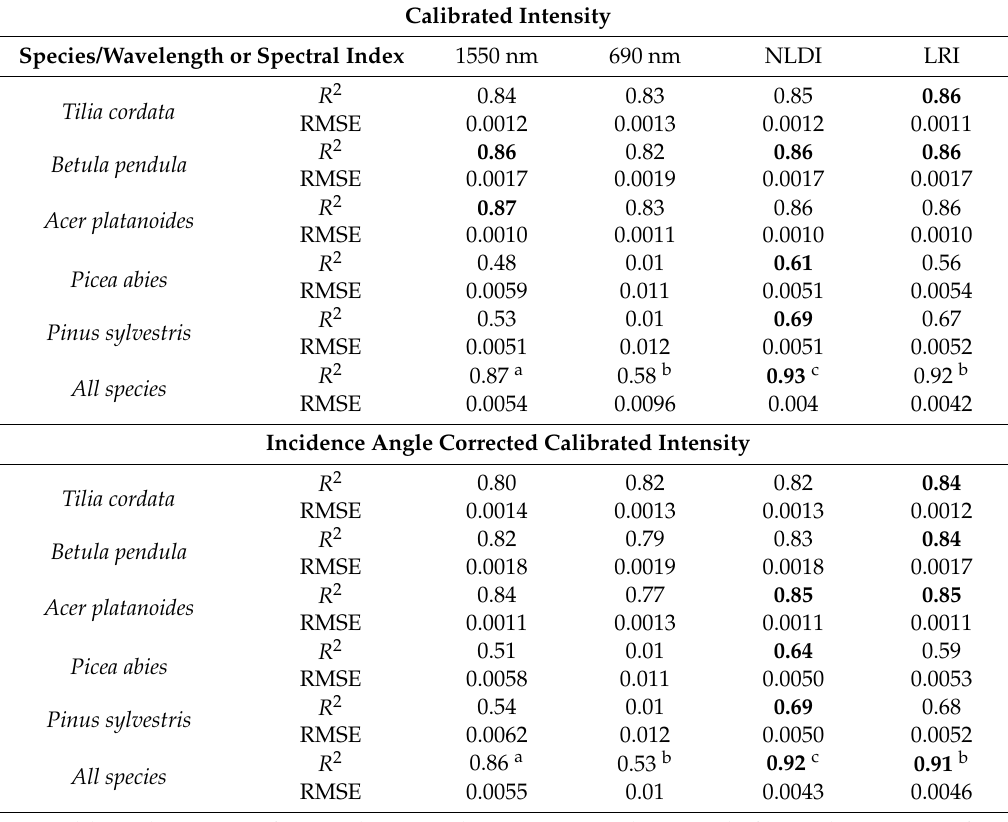
Table 4. Coefficients of determination (R 2 ) and root-mean square errors (RMSE) for the regression analyses between EWT and laser intensity features for each species separately and all species pooled